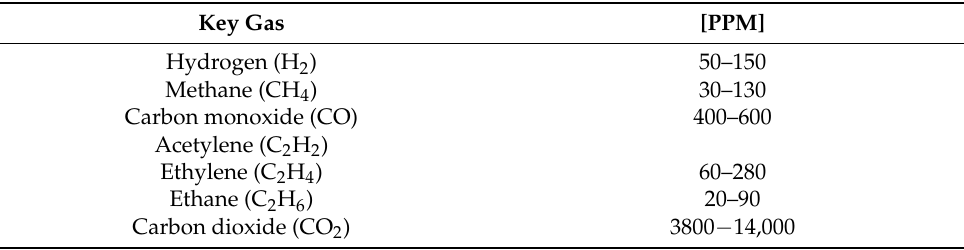
Table 2. Typical gas concentration values [18].